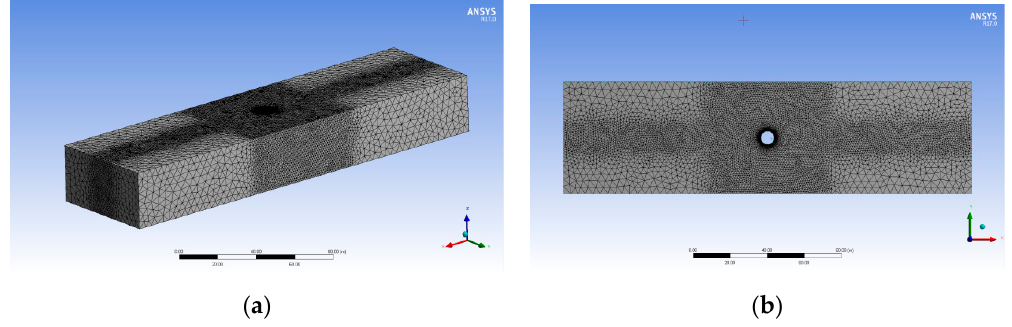
Figure 6. An example of the meshing results: ( a ) isometric view; ( b ) top view.